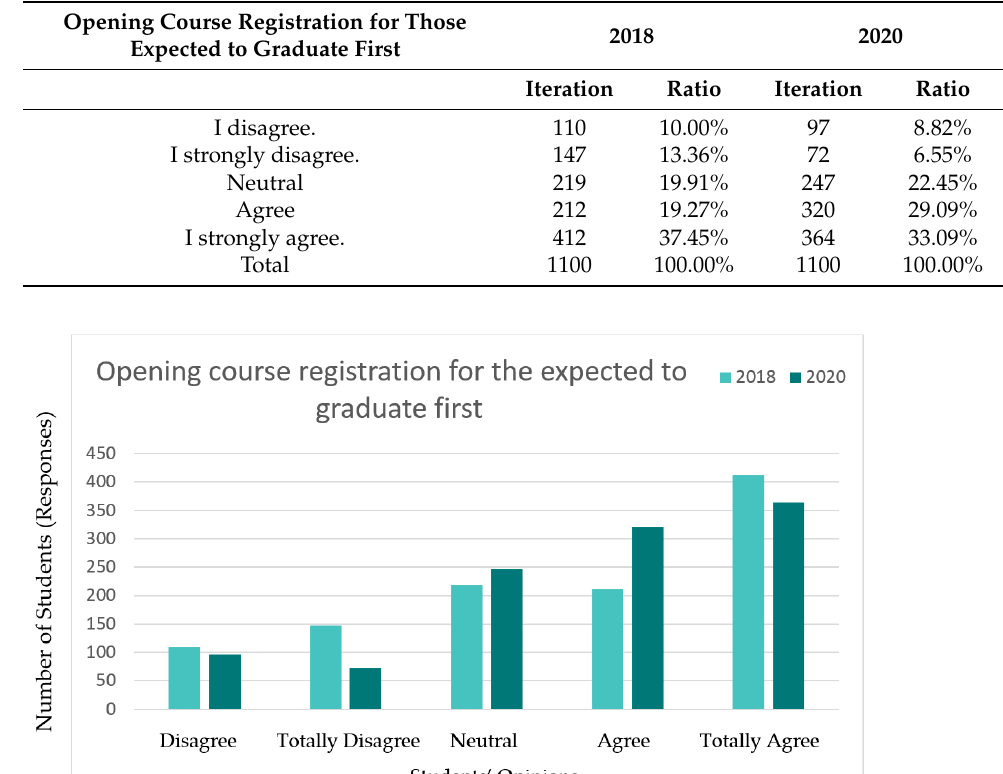
Table 8. Distribution of student numbers according to their feedback on the progressive course registration process during 2018 and 2020 survey periods.